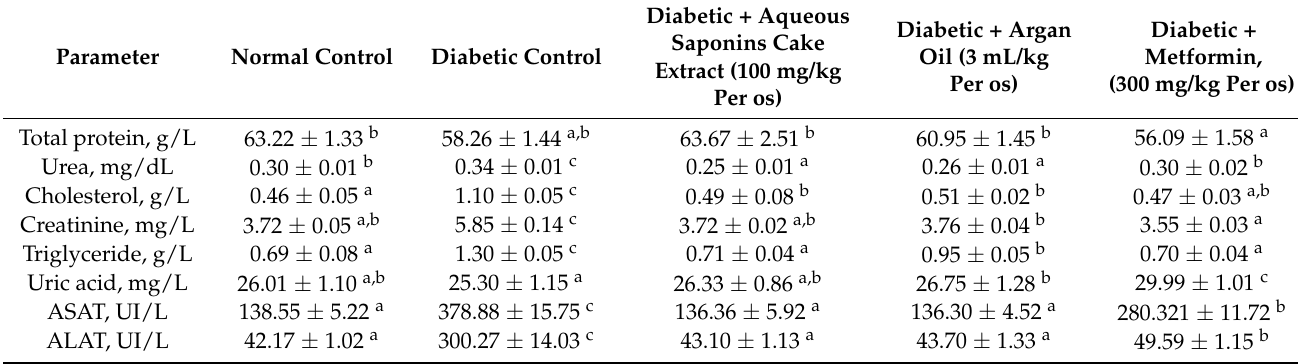
Table 7. Effects of saponin cake aqueous extract and Argan oil on biochemical parameters in alloxan-induced diabetic mice.